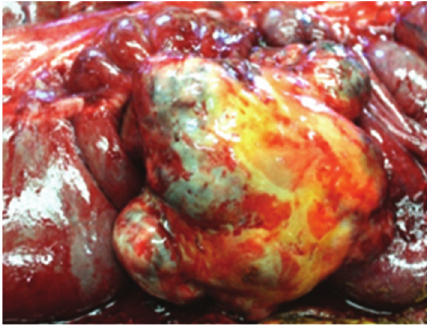
Figure 1: Necropsy revealed an approximately 10 × 10 × 8cm neoplastic mass attached by a small stalk to the external cecal wall.